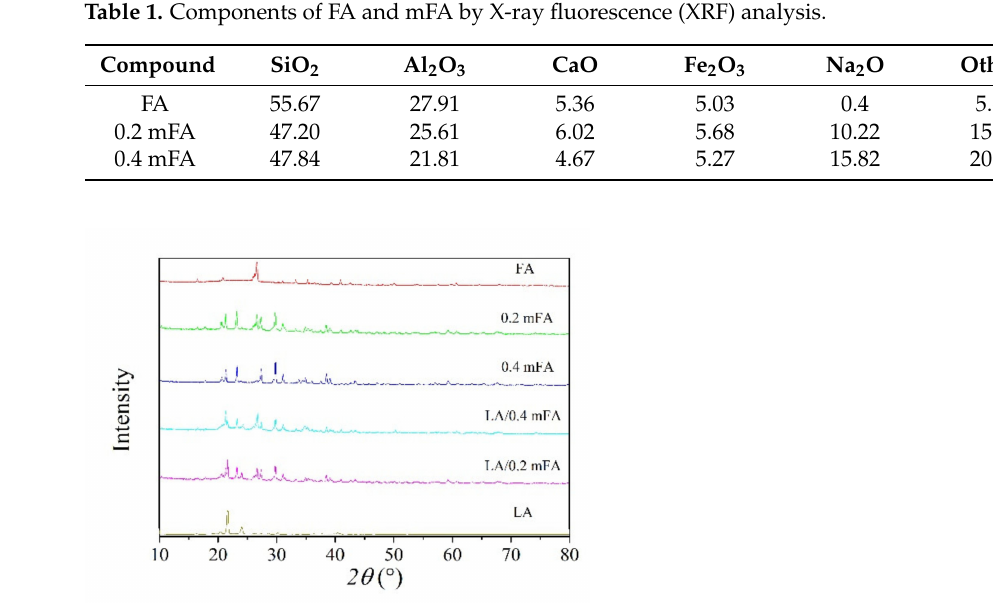
Figure 4. XRD patterns of FA, 0.2 mFA, 0.4 mFA, LA/0.2 mFA, and LA/0.4